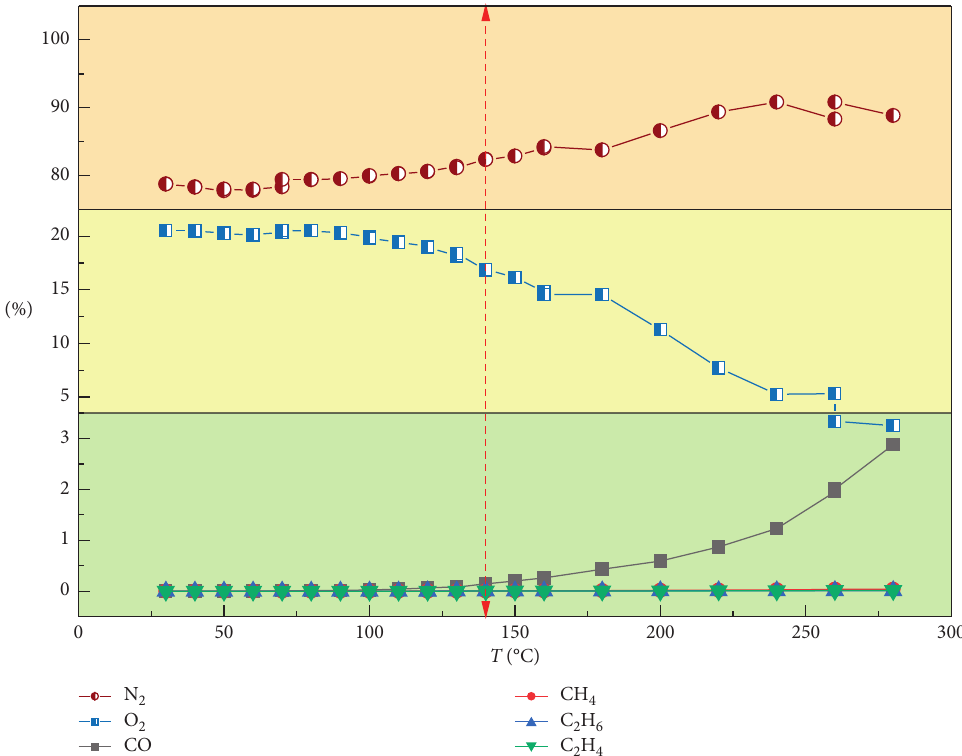
Figure 6: Gas chromatographic analysis of the coal samples under static